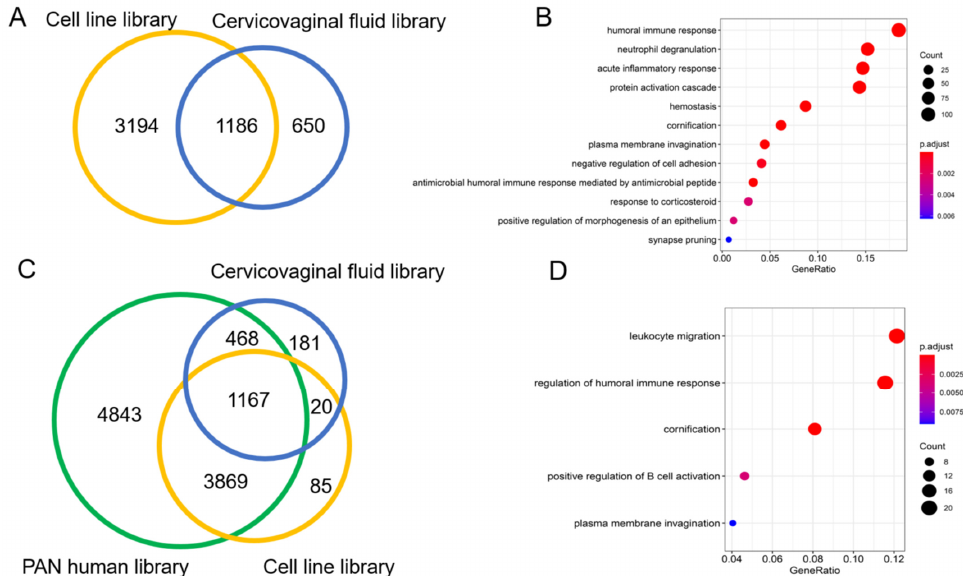
Figure 5. ( A ): Venn diagram showing overlap between the cervico ‐ vaginal fluid and the cell line spectral libraries. ( B ). Gene ontological analysis (biological function) of the 650 proteins unique to the cervico ‐ vaginal fluid library. ( C ). Venn diagram showing overlap between the cervico ‐ vaginal fluid, EC cell line and pan Human libraries. ( D ). Gene ontological analysis (biological function) of the proteins unique to the cervico ‐ vaginal fluid library. All analyses were based on proteotypic proteins.